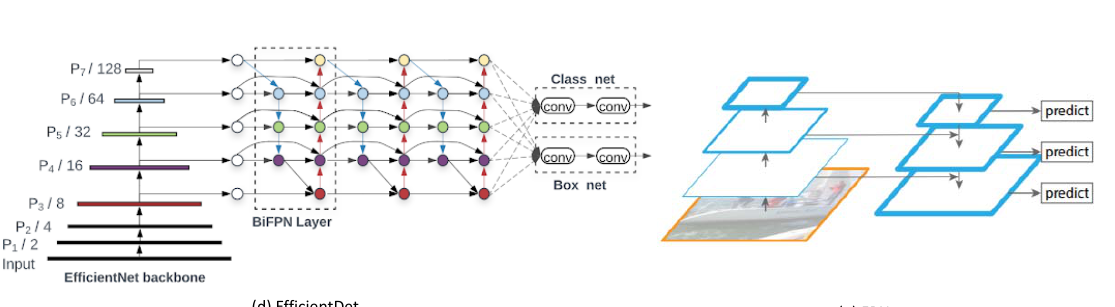
Figure 1. The architectures of the deep object detection algorithms used in this